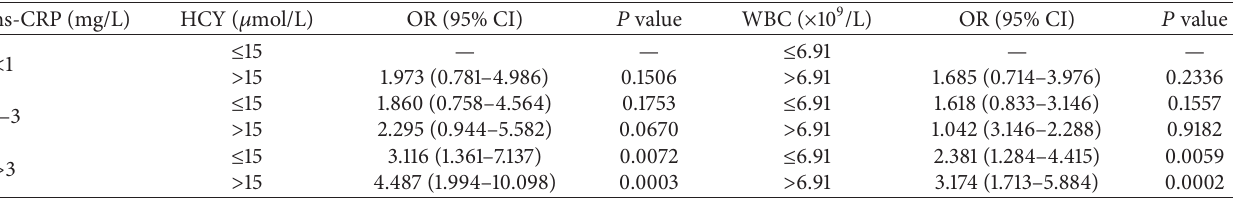
Table 4: Multivariate analysis of 1-year outcome in hs-CRP combined with HCY or